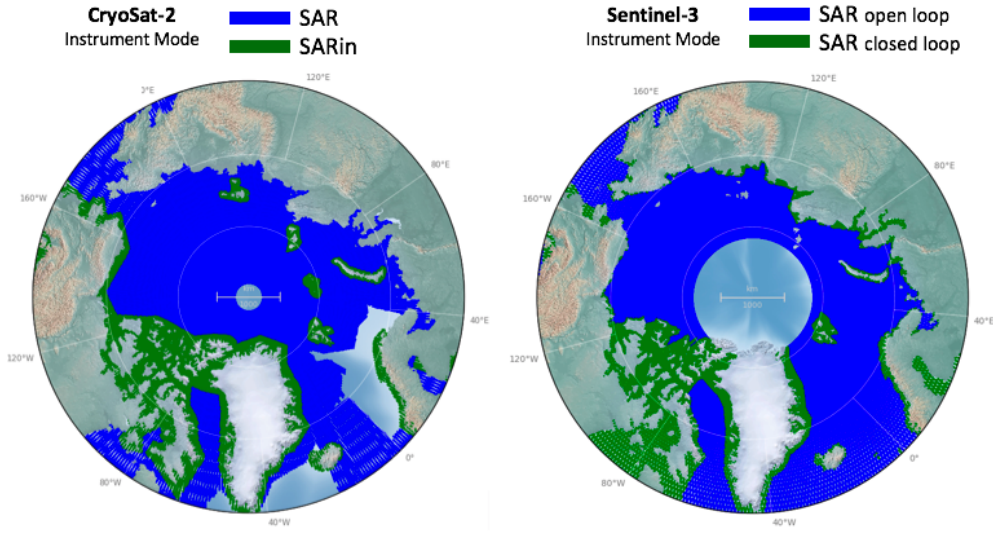
Figure 41. Instrument modes used by CryoSat-2 and S3 over the Arctic. CryoSat-2 has a smaller polar hole (region of no observations) than S3, and CryoSat-2 operated in LRM mode over the ice-free regions along the coast of Norway and around the southern cape of